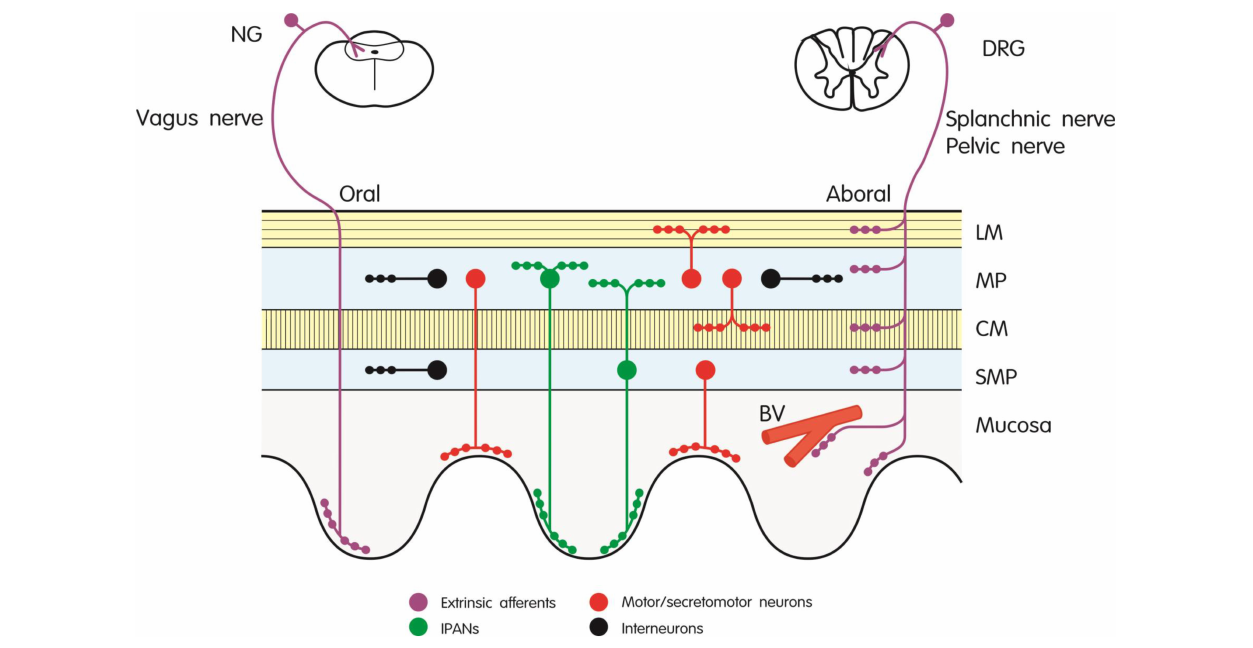
FIGURE 1 | Innervation of the rodent gut by extrinsic afferent and intrinsic enteric neurons expressing CGRP. The different types of neuron are depicted by different color codes as explained in the graph. BV, blood vessel; CM, circular muscle; DRG, dorsal root ganglion; IPANs, intrinsic primary afferent neurons; LM, longitudinal muscle; MP, myenteric plexus; NG, nodose ganglion; SMP, submucosal